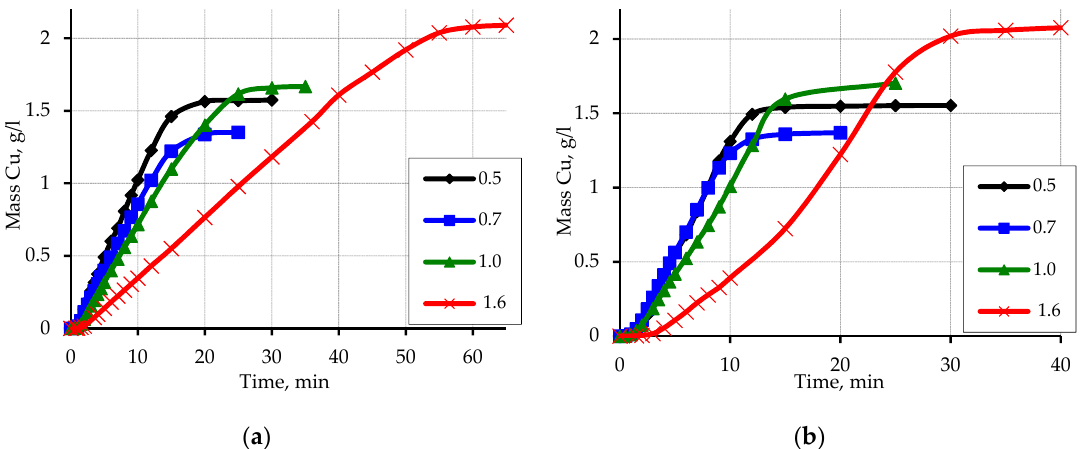
Figure 8. Kinetic curves of copper ion reduction on the activated surface of polypropylene depending on